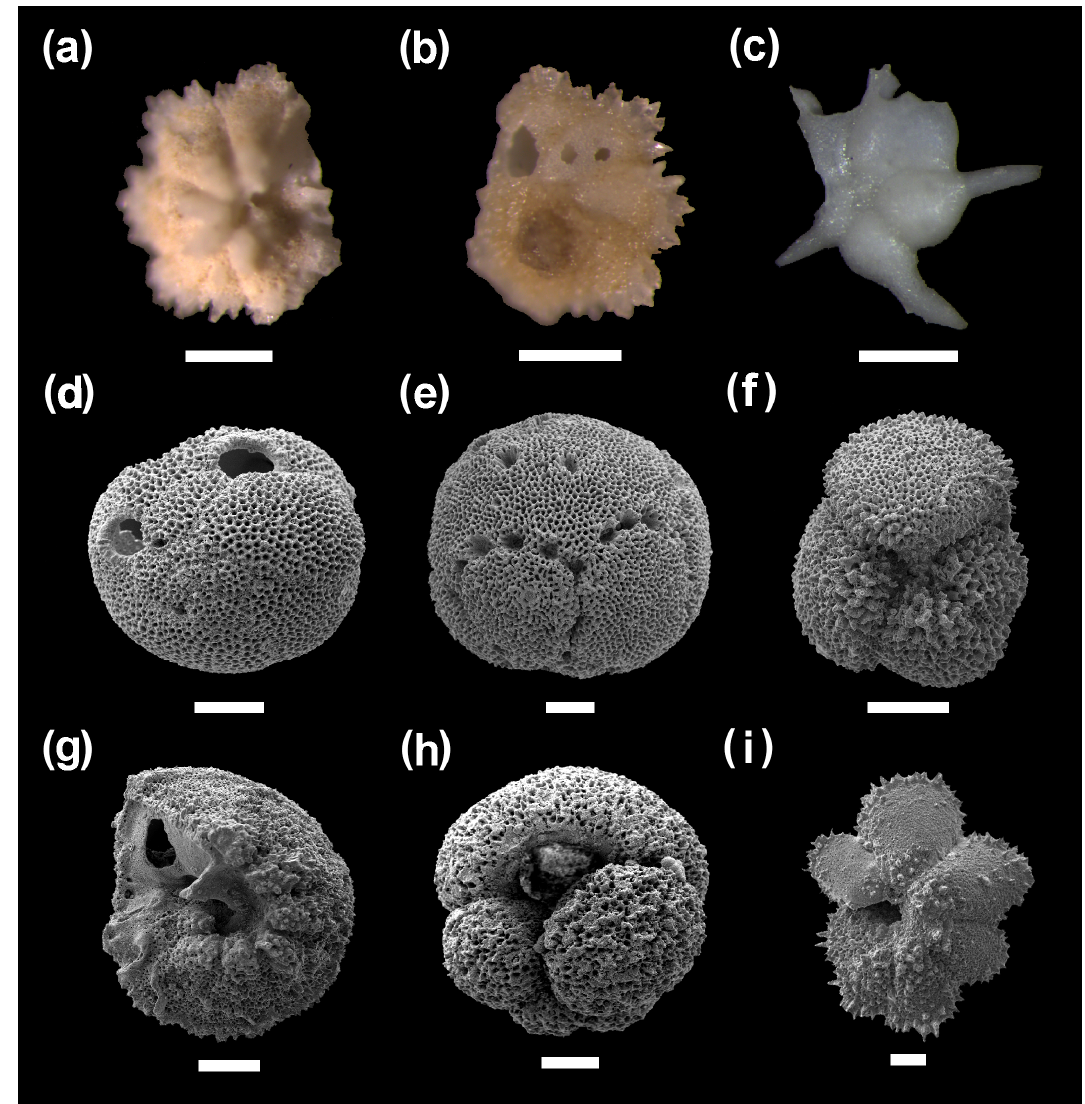
Figure 4. Scanning electron and light microscope images of biostratigraphically important taxa at ODP Site 865. (a, b) Sample ODP Hole 865C-4H-2, 25–27cm, Morozovelloides lehneri – reworked specimens with distinctive brown/orange discolouration. (c) Sample ODP Hole 865B-6H-1, 73–75cm, Hantkenina australis . (d) Sample ODP Hole 865C-4H-2, 85–87cm, Globigerinatheka semiinvoluta , broken final chamber. (e) Sample ODP Hole 865C-5H-1, 5–7cm, Orbulinoides beckmanni . (f) Sample ODP Hole 865C-5H-4, 85–87cm,